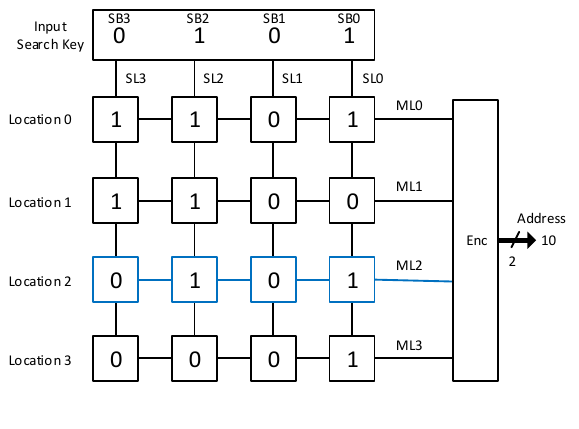
Figure 1. A 4 × 4 BCAM. (SL0, SL1, SL2, and SL3 are the four search lines; ML0, ML1, ML2, and ML4 are the four matchlines; Enc.: A priority